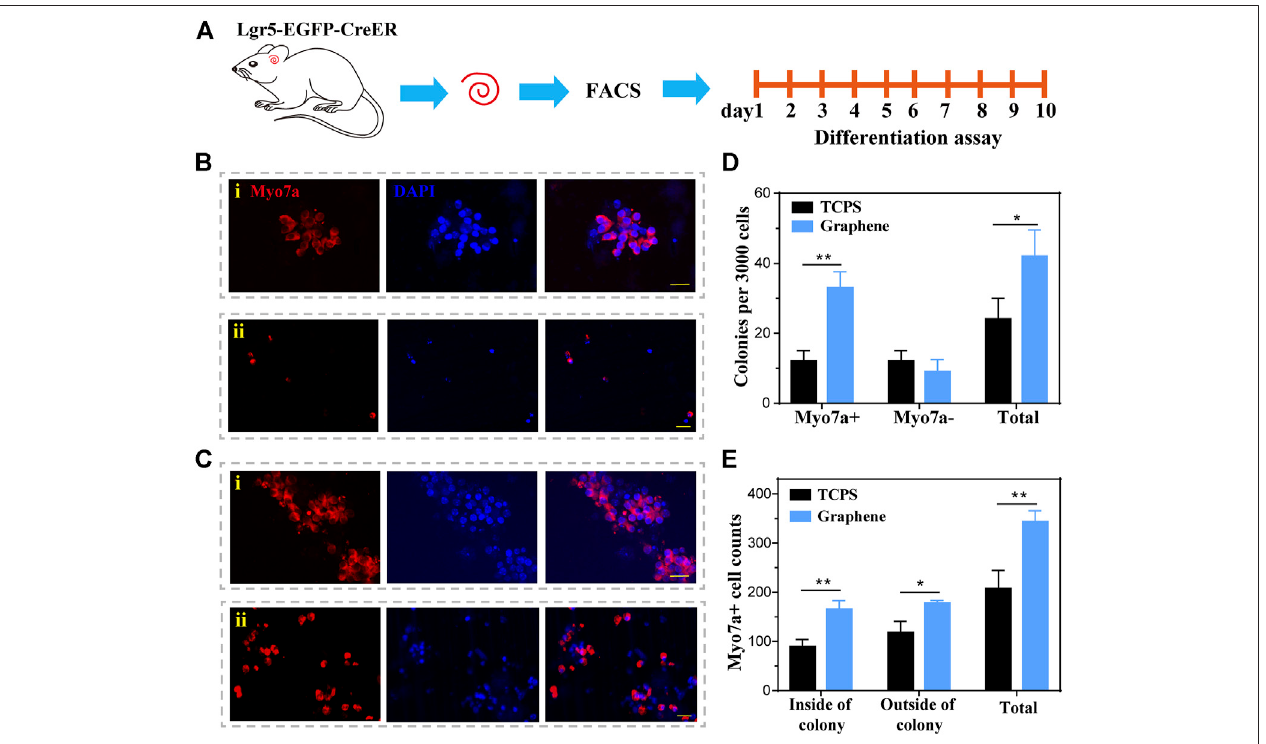
FIGURE 5 | The differentiation of Lgr5+ progenitors. (A) The Lgr5+ progenitors were cultured on graphene or TCPS for 10 days of differentiation. (B) Immuno fl uorescence images of Lgr5+ progenitors cultured on TCPS after 10 days of differentiation, both inside (i) and outside (ii) the colony. (C) Immuno fl uorescence images of Lgr5+ progenitors cultured on graphene substrates after 10 days of differentiation, both inside (i) and outside (ii) the colony. (D) The number of colonies per 3,000 cells. (E) Quanti fi cation of Myosin7a+ cells. The scale bars are 20 μ m in (B,C)